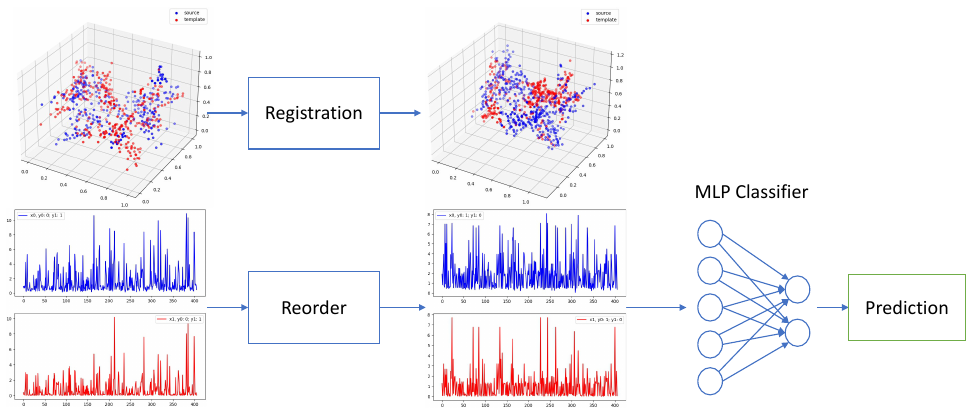
Figure 1. Our proposed registration and classification framework. We first align all EAMs to the same template point cloud via 3D point cloud registration. Then we reorder uni/bipolar voltages of corresponding points by their L1 distance to the original point. We feed the reordered voltages into an MLP for classification in the